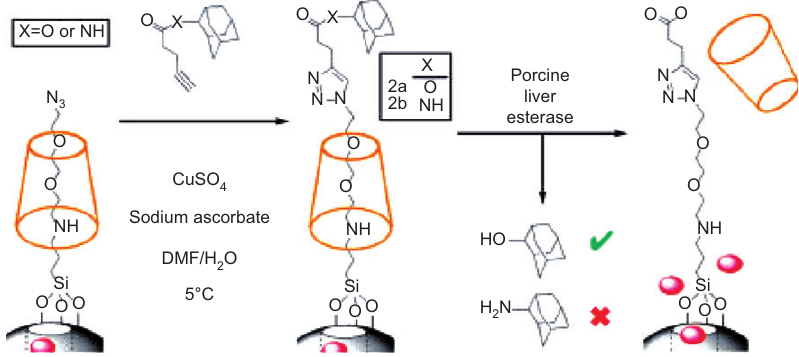
Figure 9 Synthesis and activation of enzyme-responsive snap-top system [48] . Reprinted (adapted) with permission from Ref. [48] . Copyright (2008) American Chemical